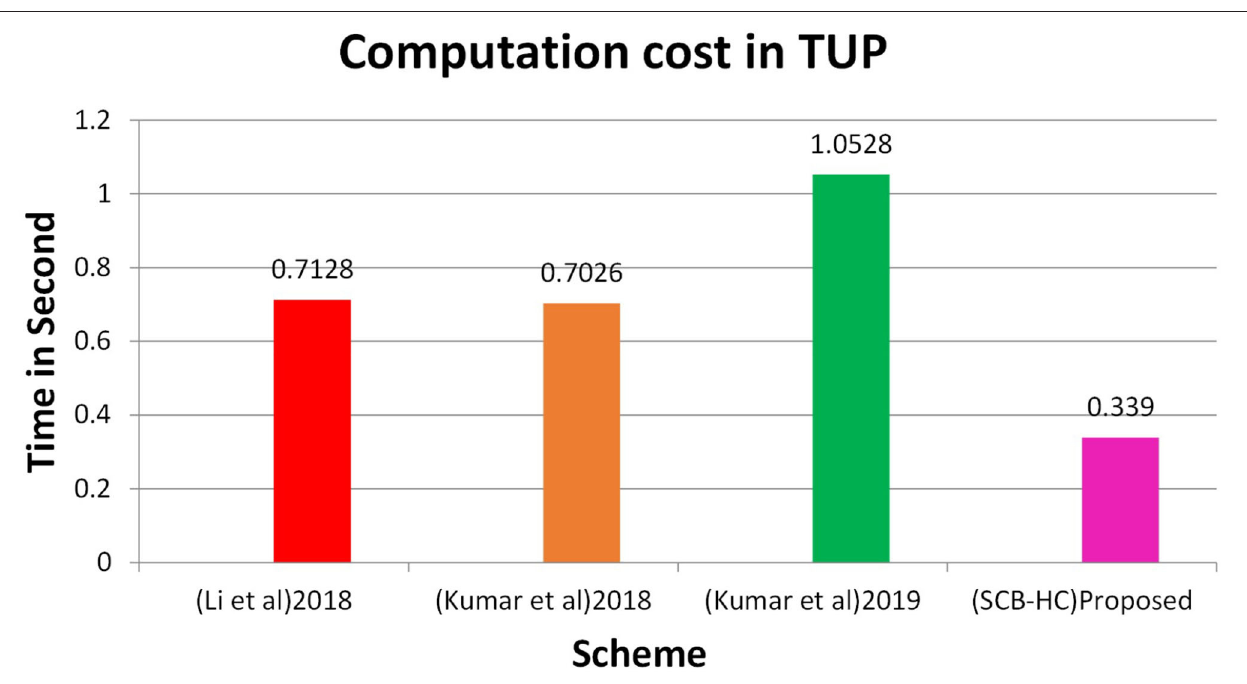
FIGURE 3 | TUP computation